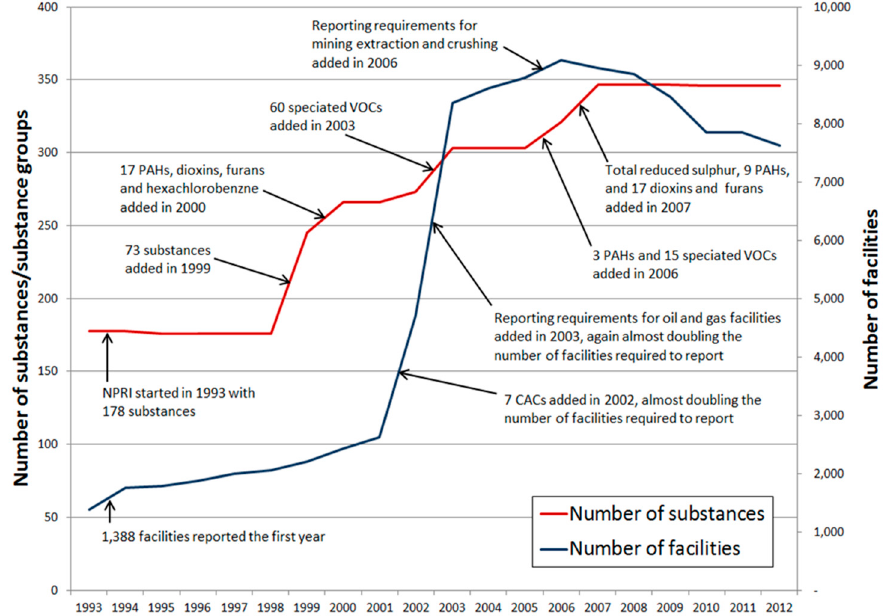
Figure 1. Changes made to the NPRI substance list over time (adapted from ECCC [10]).